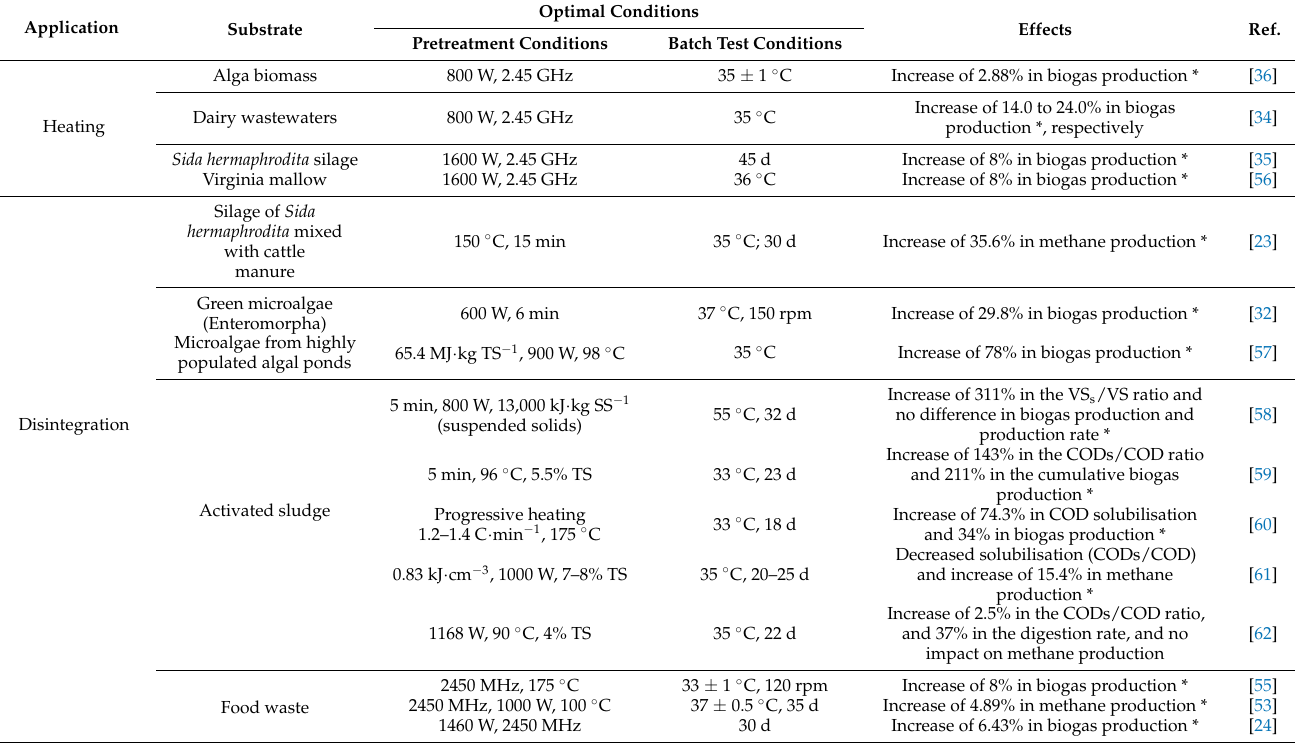
Table 2. Possibility of using EMR in anaerobic